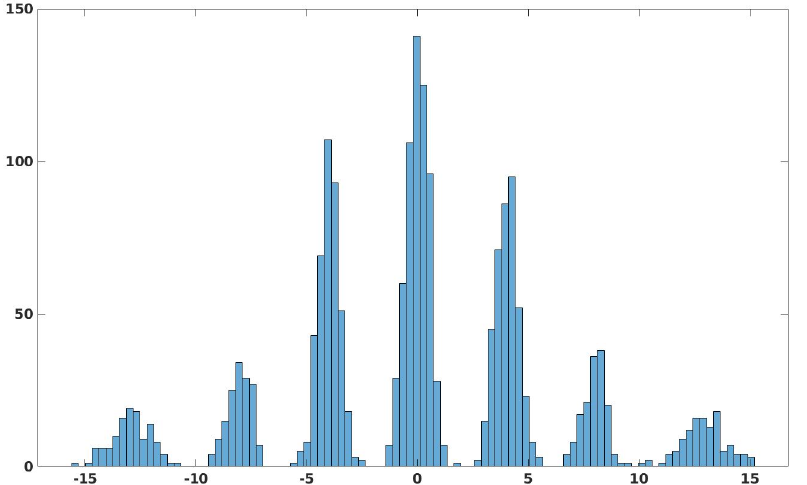
Figure 5. The recompression of the genuine region of the image.